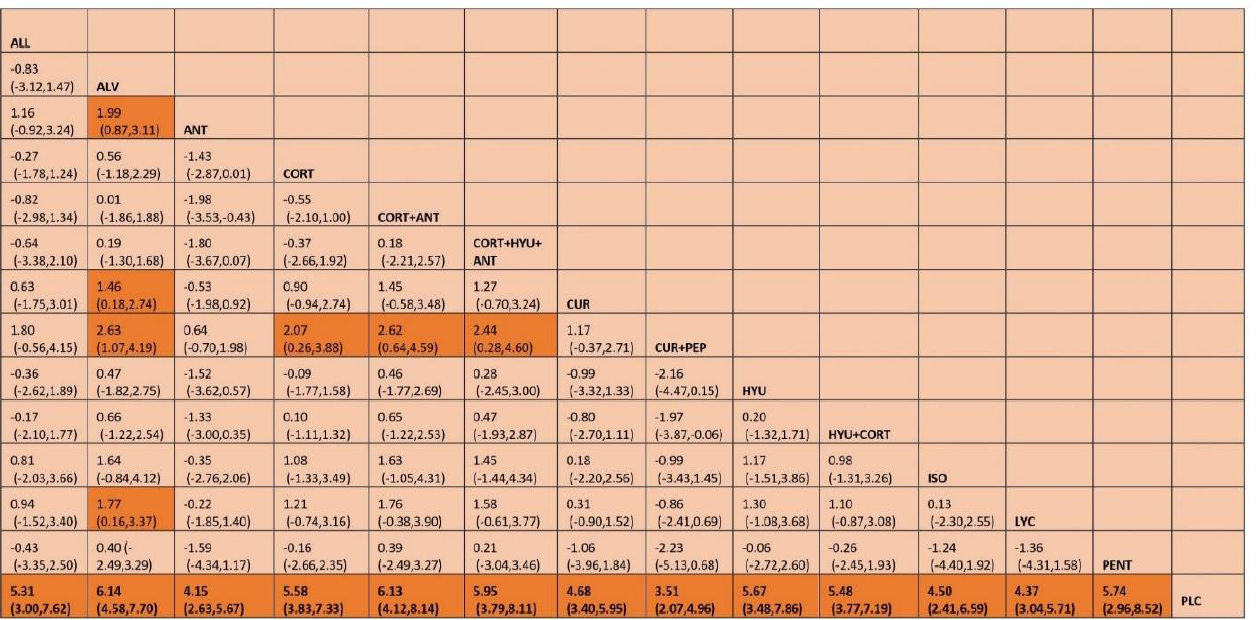
Figure 6. SUCRA ranking curve for the comparative efficacy of different interventions used in the management of OSMF (Burning sensation) Abbreviations: HYU — hyaluronidase; CORT — corticosteroid; LYC — lycopene; ALL — allicin; ANT — antioxidant; CUR — curcumin; ALV — aloe vera; PEP — piperine; PLC —